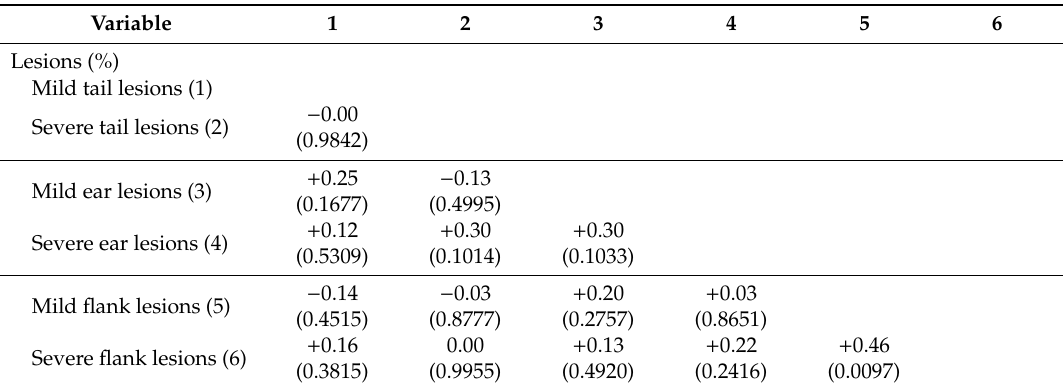
Table 2. Correlations between the prevalence of finisher pigs with associated tail-, ear-, and flank-lesions on 31 farrow-to-finish pig farms. p -values are given in brackets.